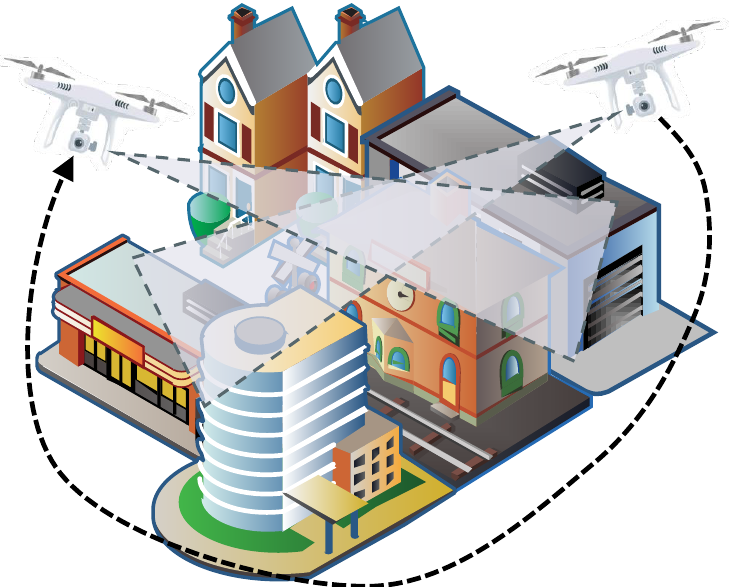
Figure 1. Path Planning for Scene Understanding with